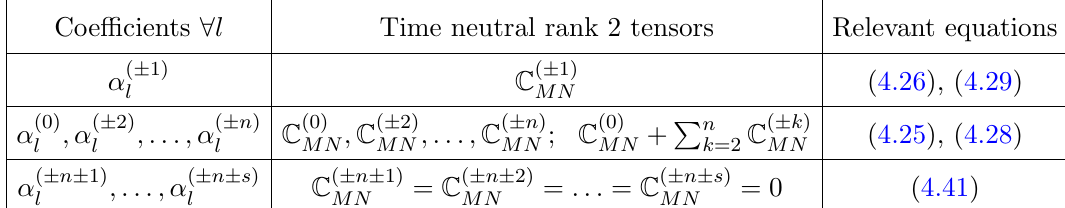
Table 1 . The full contributions from the quantum e(cid:11)ects in the energy-momentum tensor to the EOMs. Since both n and s can be arbitrarily large, the second row elucidates the loss of an e(cid:11)ective (cid:12)eld theory description, whereas the third row provides an exact solution to the constraint